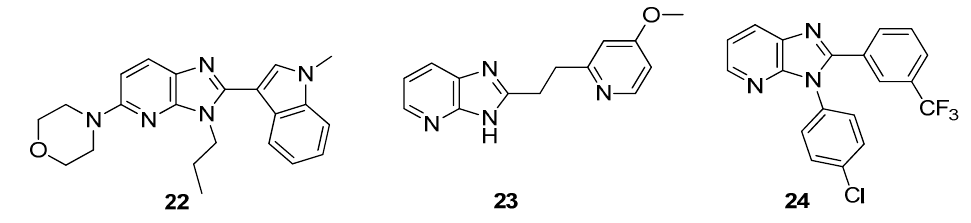
Figure 8. Anti-inflammatory imidazo[4,5- b ]pyridines.